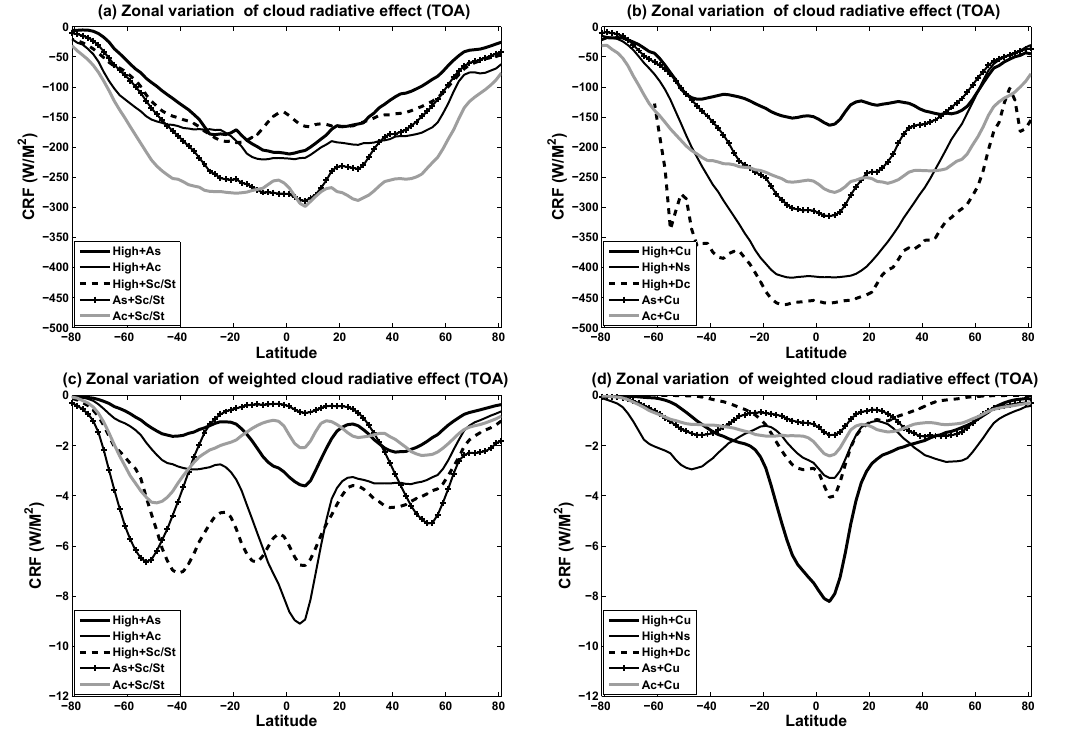
Figure 5. (a–d) The zonal distributions of instantaneous net cloud radiative effect and weighted instantaneous net cloud radiative effect by considering the frequency of occurrence of each cloud type for different multilayered cloud systems at the TOA during daytime (that is, overpass time of